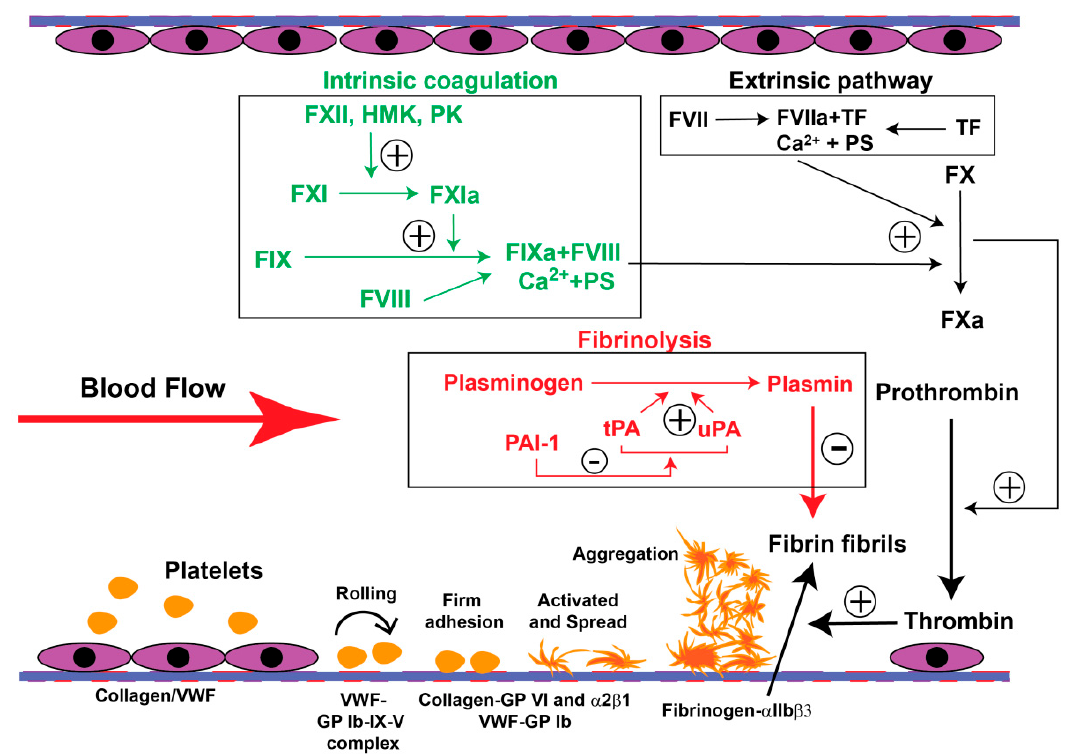
Figure 1. Schematic illustration of human hemostasis. Hemostasis begins at the site of vascular injury. Platelets first adhere to the exposed subendothelium and, through multiple ligand–receptor interactions, are activated and aggregate by fibrinogen crosslinking to form a plug to seal the wound. Anionic phospholipids exposed on the surface of activated platelets also trigger coagulation through a series of enzymatic actions of coagulation factors (e.g., inactive factor X (FX) to activated FX (Fxa)), resulting in the eventual activation of thrombin, which cleaves fibrinogen to generate fibrin fibrils that crosslink and stabilize the platelet plug to arrest bleeding. The fibrin fibrils then activate the fibrinolysis pathway that generates plasmin to cleave these fibrils to re-establish circulation. VWF: von Willebrand factor; TF: tissue factor; PS: phosphatidylserine; HMK: high molecular weight kininogen; PK: prekallibrein; tPA: tissue plasminogen activator; uPA: urokinase.